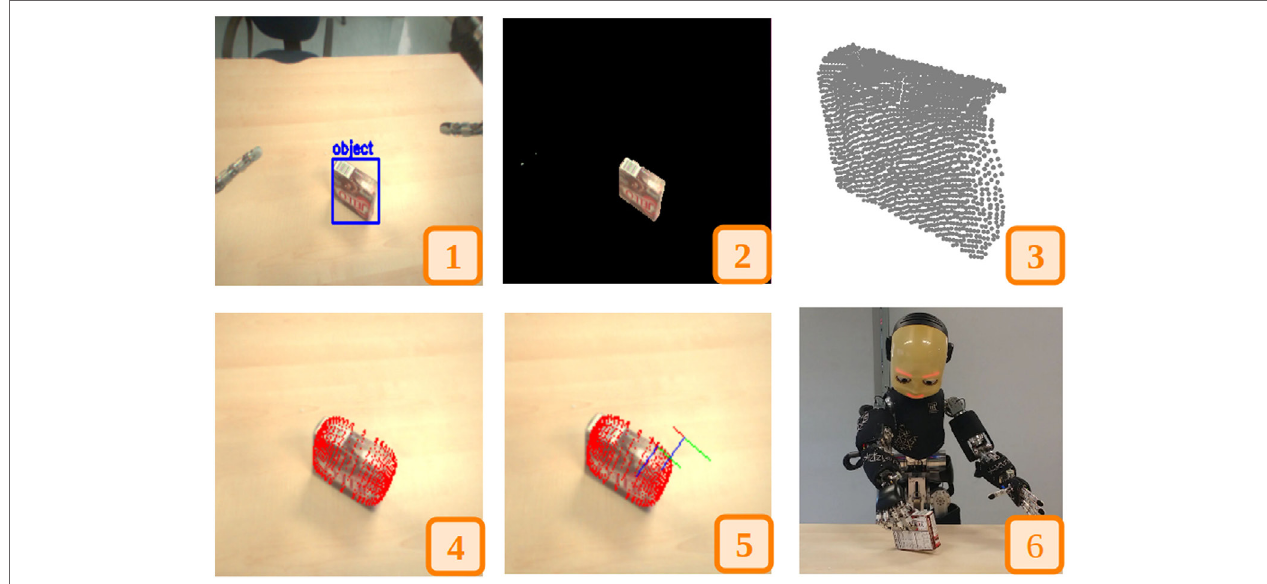
FIGURe 3 | Outcomes of the modeling and grasping pipeline. (1) The object is stored by the object property collector with the label object . (2) LbpExtract provides the 2D blob of the object. (3) The 3D point cloud is extracted from the disparity map, by querying the Structure From Motion module. (4) The superquadric modeling the object is reconstructed. (5) The grasping pose and approaching trajectory for the right hand are computed. (6) The robot grasps the object. (Steps (1), (2), (4), and (5) are represented by screenshots from the